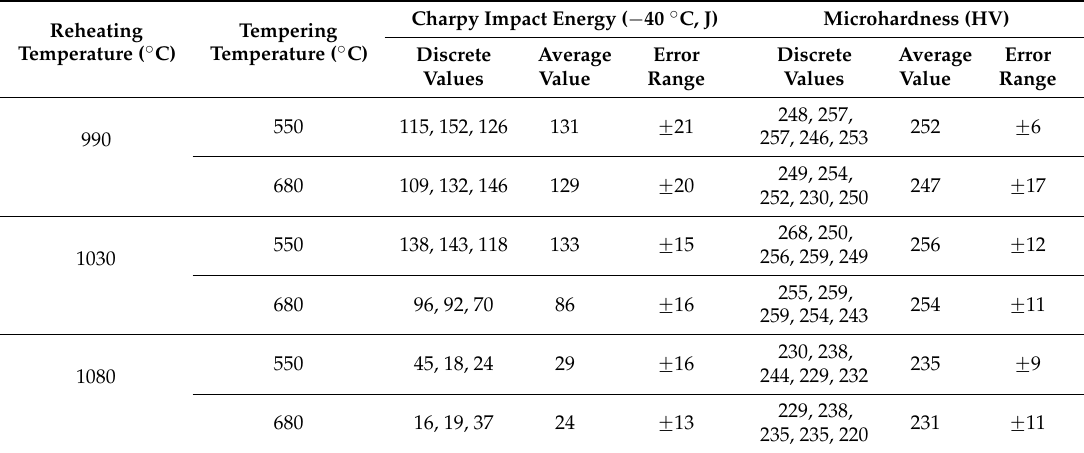
Table 2. Toughness and microhardness of the weld